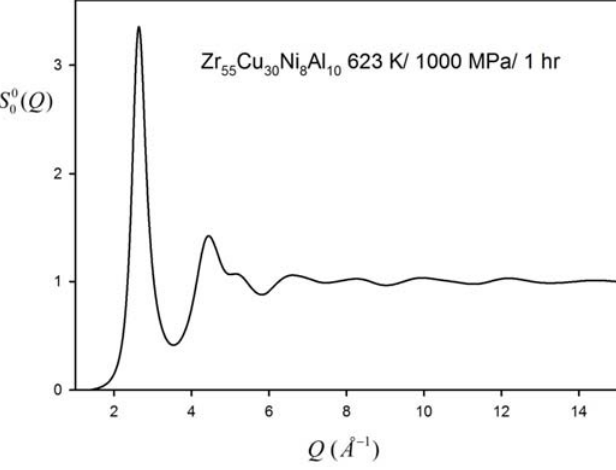
Figure 2. Isotropic structure function S 0 0 ( Q ) for a sample creep deformed at 623 K under 1 GPa for 1 h.